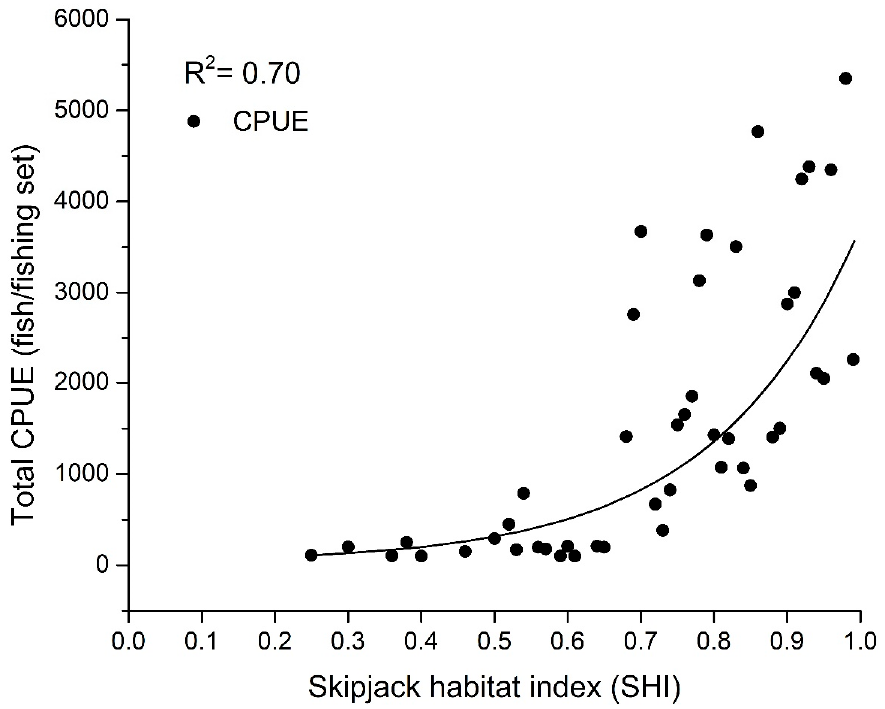
Figure 8. A scatter plot of the skipjack habitat index (SHI) against total CPUE values ( p < 0.0001, R 2 = 0.70).